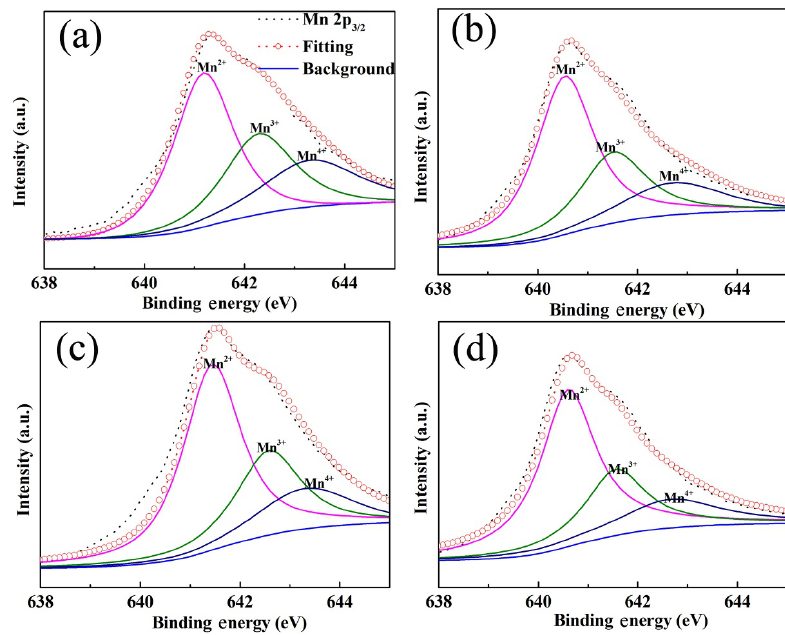
Fig. 10 High-resolution Mn 2p 3/2 XPS spectra from (a) A0, (b) A1, (c) A2, and (d) A3 ceramics. Table 3 Relative concentration of Co, Mn ions, and thermopower Q values in different ceramics Co 2p Mn 2p Ceramic